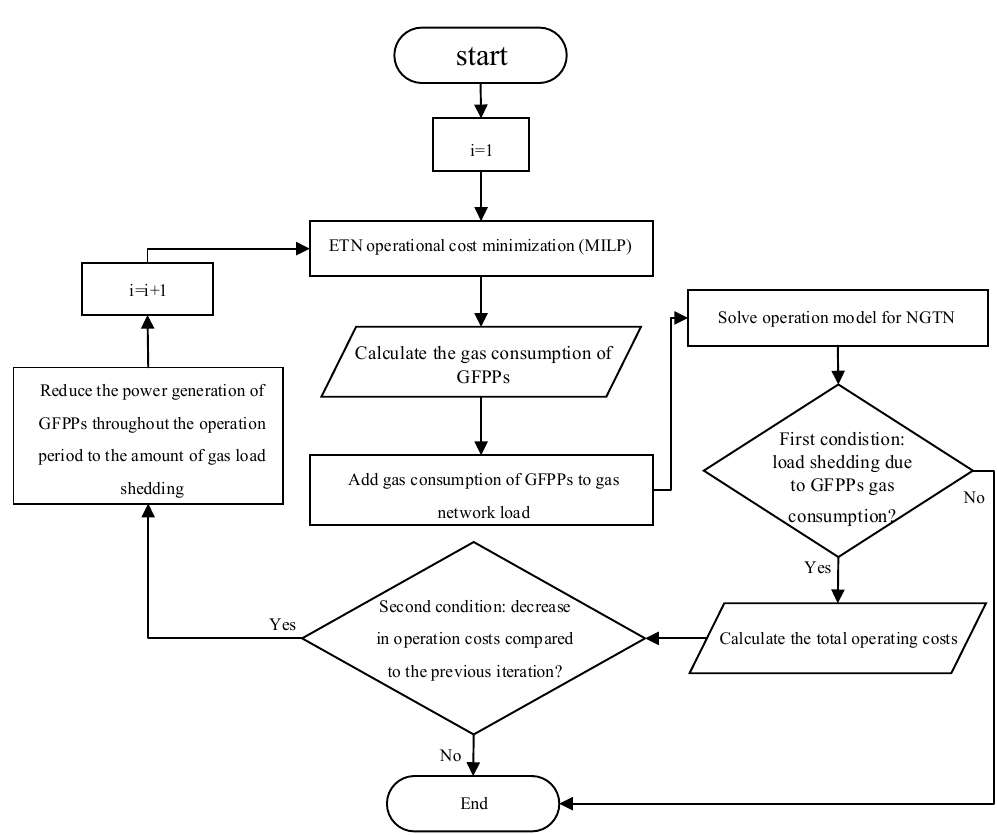
Figure 1. Flowchart of the enhanced separated